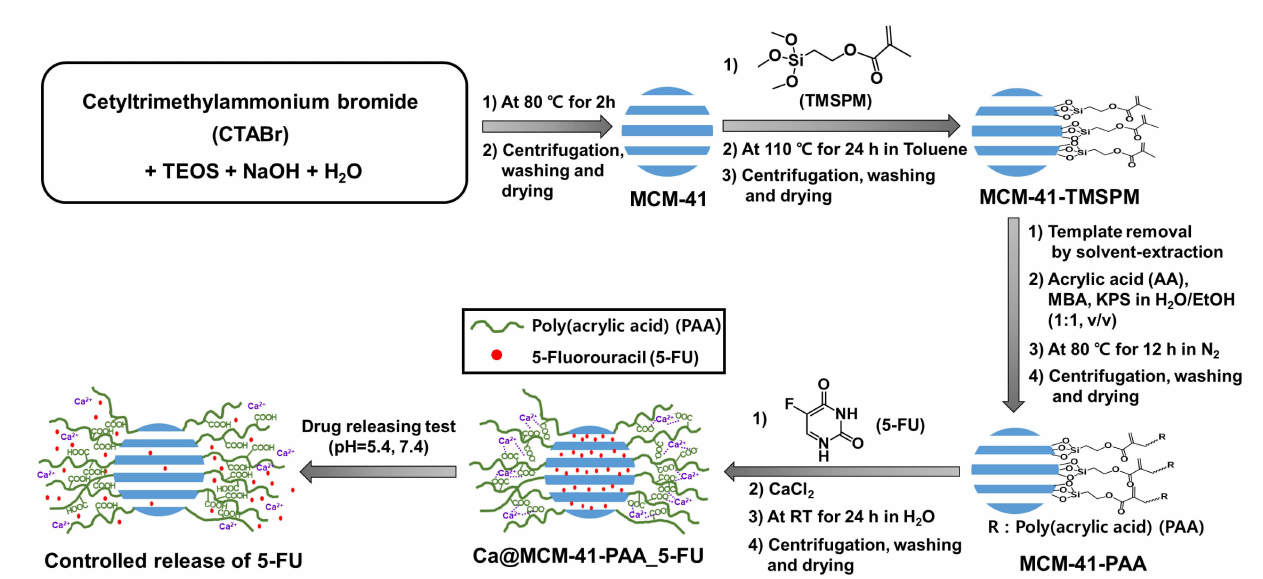
Scheme 1. An illustration for the preparation of Ca@MCM-41-PAA_5-FU and the releasing behavior of drug molecules in pH